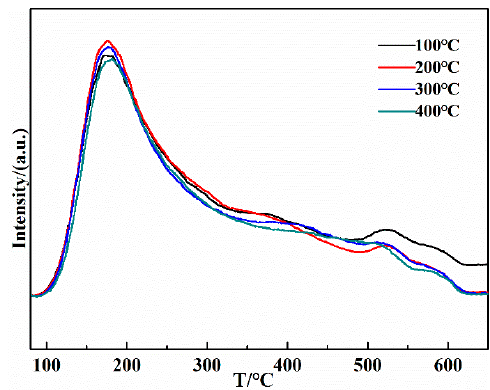
Figure 8. NH 3 -TPD profiles of 10 wt% NiP/H β calcined at different temperatures.